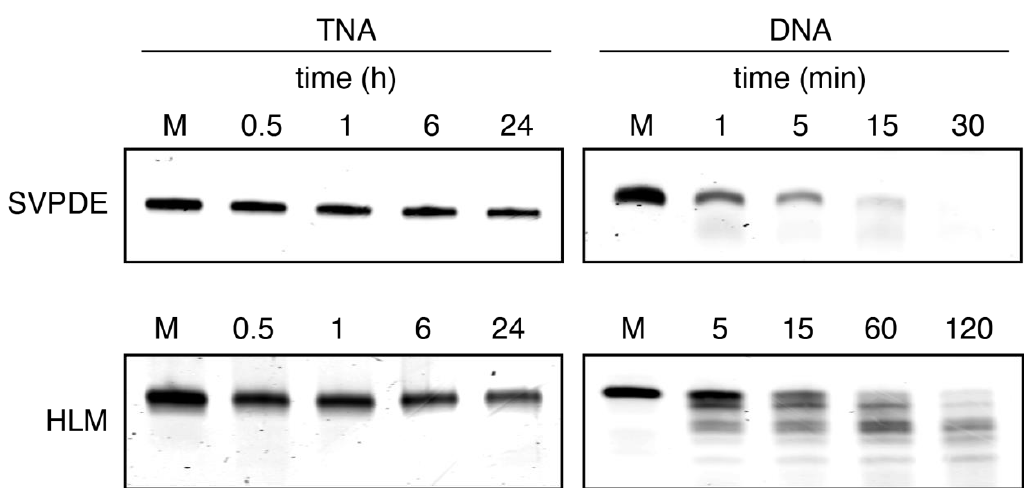
Figure 4. Biological stability assays. Time-dependent assays were performed using snake venom phoshpodiesterase (SVPDE) and human liver microsome (HLM) to evaluate the biological stability of ATP-binding TNA and DNA aptamers. M is a marker for the 0-time point with no enzyme.